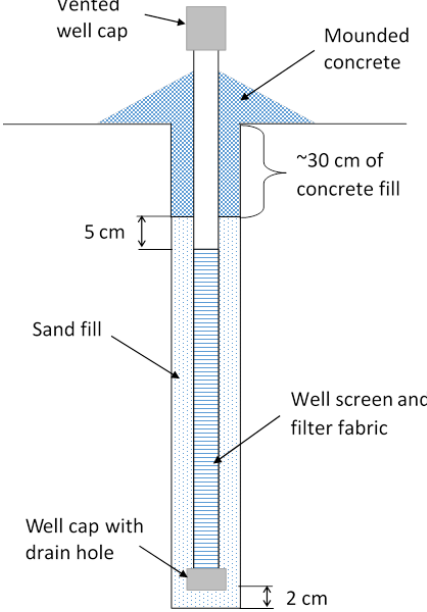
Figure 3. Schematic of the water table monitoring wells installed (adapted from Sprecher,